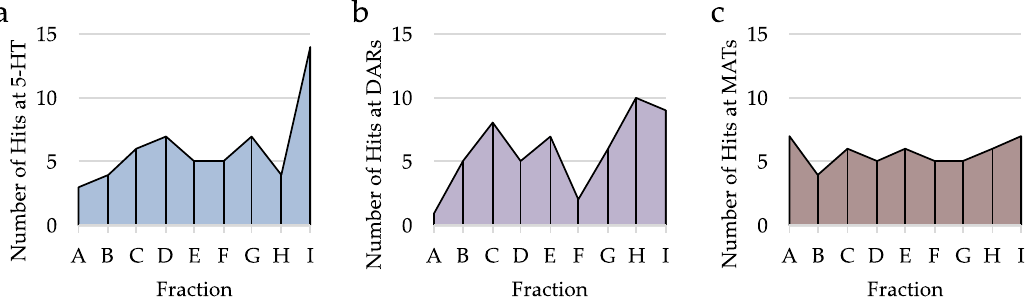
Figure 10. Analysis of number of hits by fraction. ( a ) Number of hits per fraction at 5-HTRs (60 hits total). ( b ) Number of hits per fraction at DARs (57 hits total). ( c ) Number of hits per fraction at MATs (54 hits total).